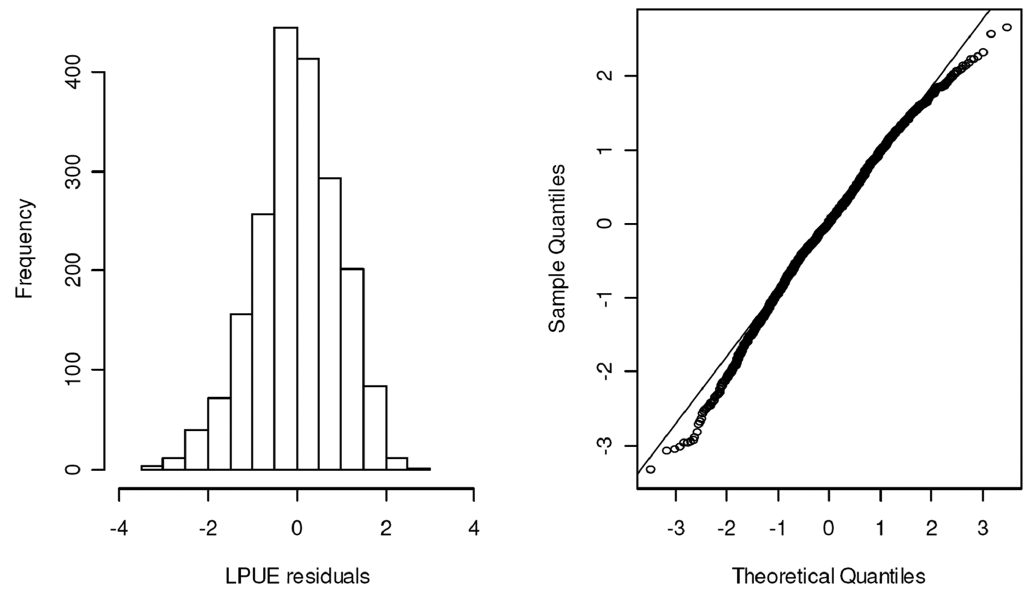
Fig . 4. – residuals plots for the glM used to standardise black scabbardfish lPue.